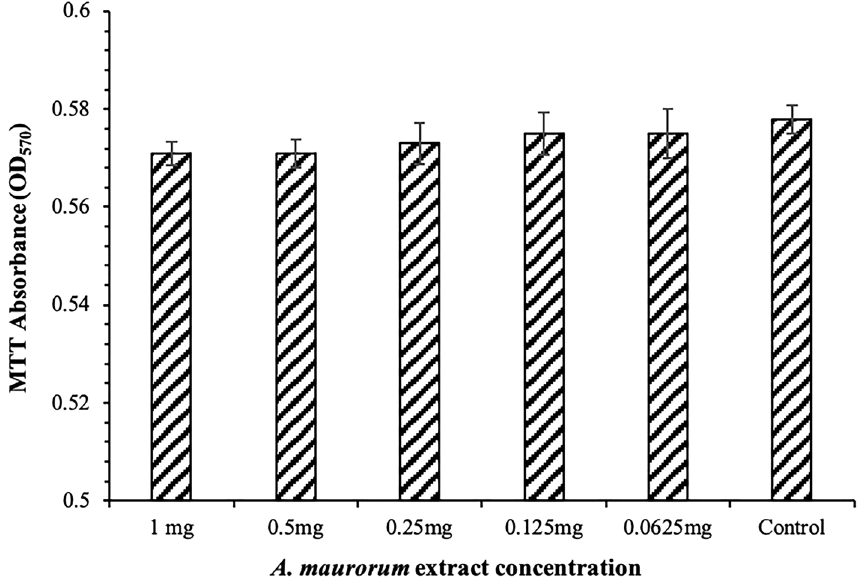
Figure 7. Survival assay with MTT. The absorbance of different concentrations of AME at OD570